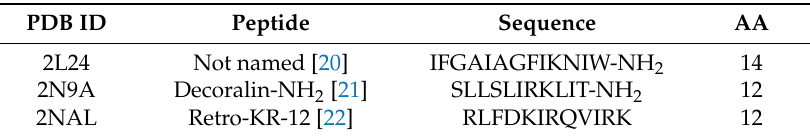
Table 2. Sequences of antimicrobial peptides whose 3D structure has been determined in the absence of